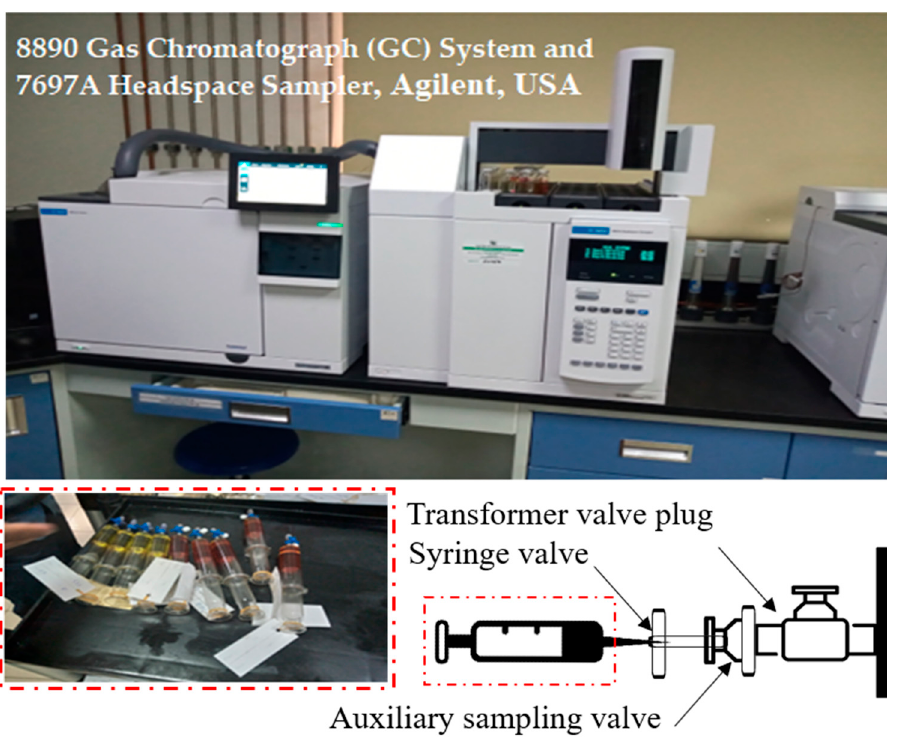
Figure 5. Drawing the oil sample from the transformer and the 8890 Gas Chromatograph (GC) System and 7697A Headspace Sampler, Agilent, USA.